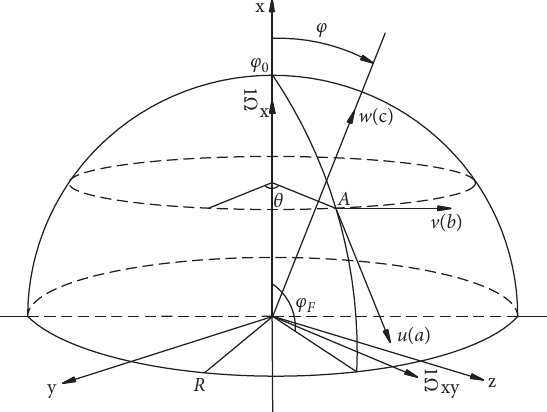
Figure 1: The coordinate of the hemispherical